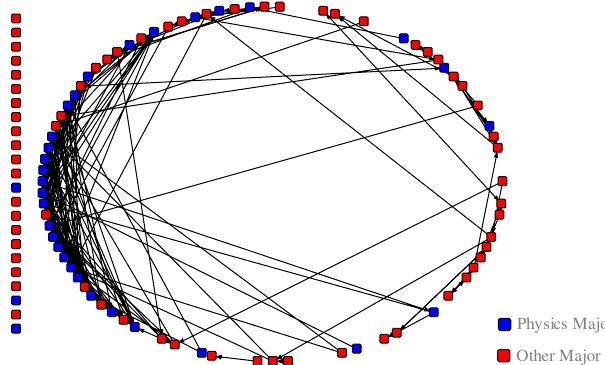
FIG. 4 (color online). Sociogram of Physics Learning Center participation. Nodes represent students, ties represent self- reported collaboration, red squares are not physics majors, blue squares are physics